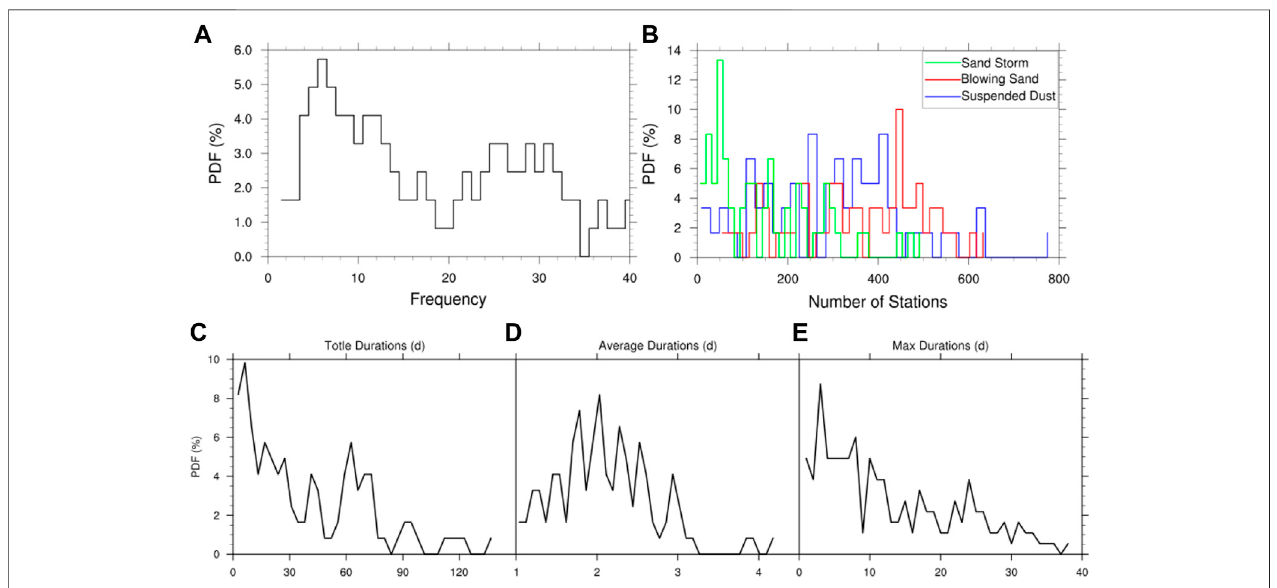
FIGURE 6 | Probability distributions of (A) annual total frequency, (B) maximum number of affected stations, (C) annual total days, (D) average days, and (E) maximum duration for different categories of sand-dust processes.